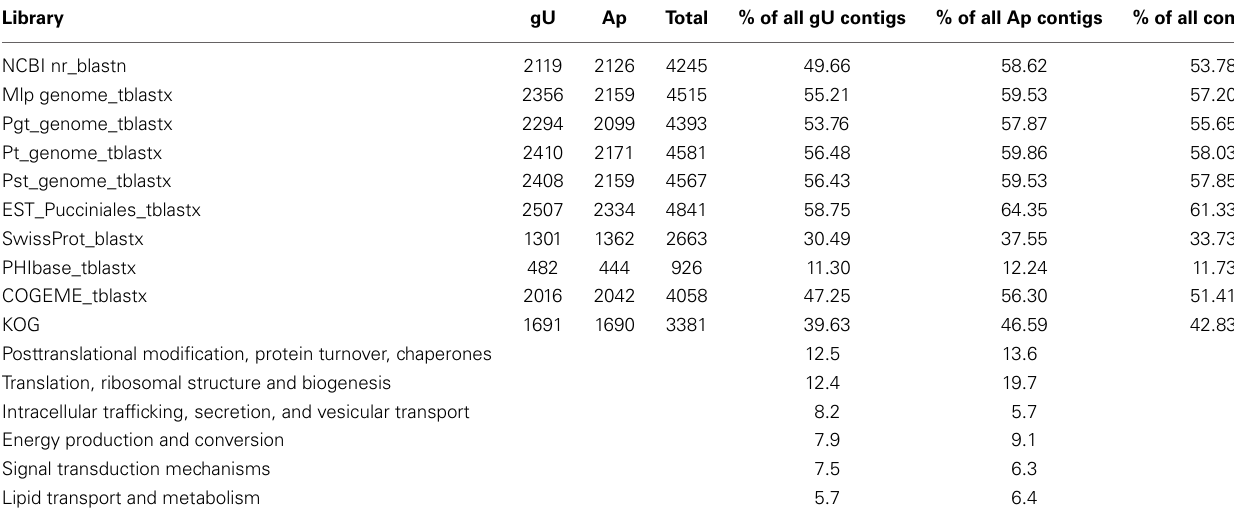
Table 2 | Hemileia vastatrix transcript homology in databases and KOG functional categories